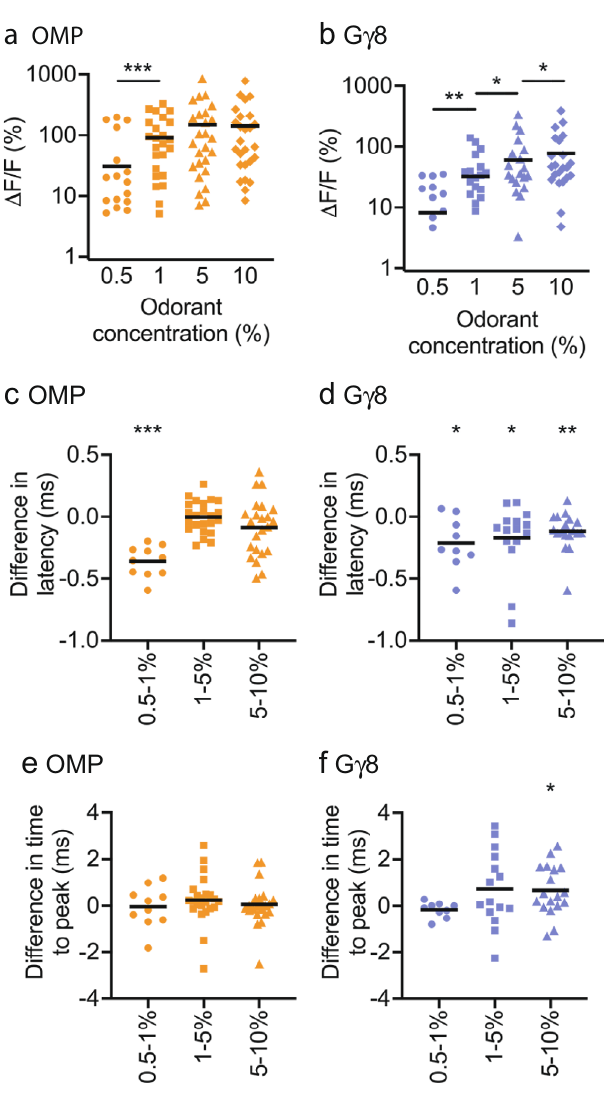
Fig. 4 | Immature OSNs provide information about differences between high odorant concentrations. a Odorant response amplitudes increase signi fi cantly between 0.5 – 1% concentrations but are similar across higher concentrations